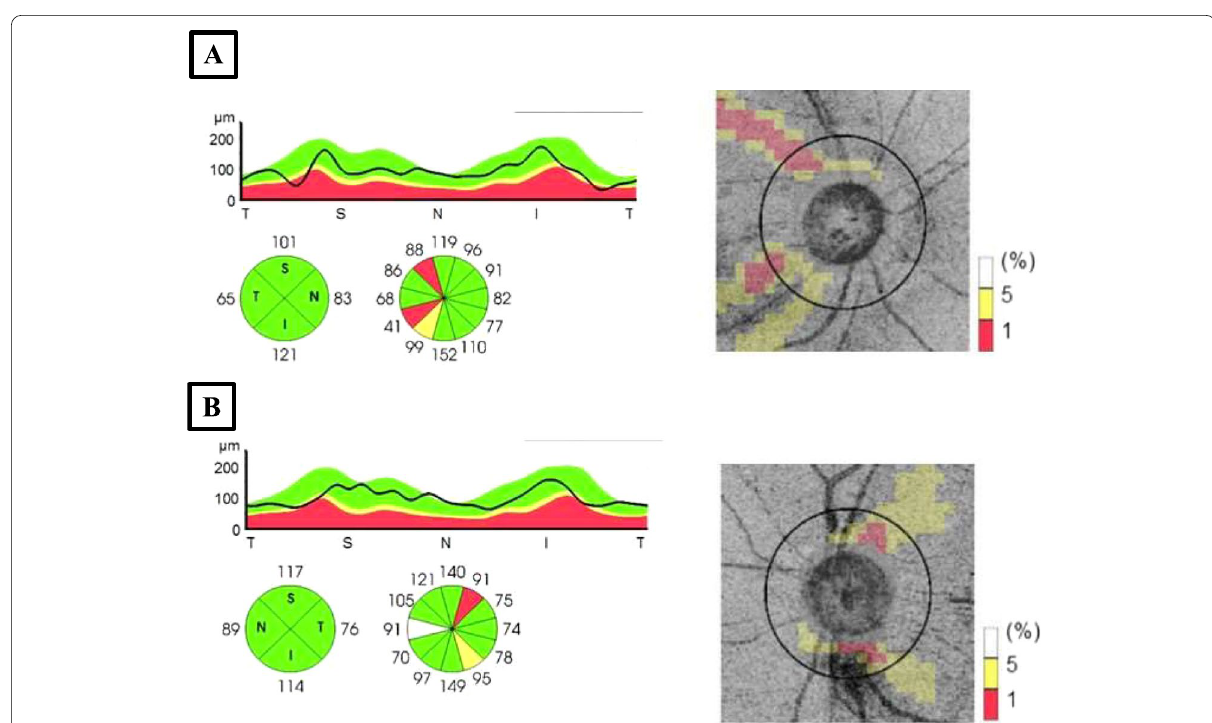
Fig. 5 Retinal nerve fibre layer report showing defects in both eyes. A right eye; B left